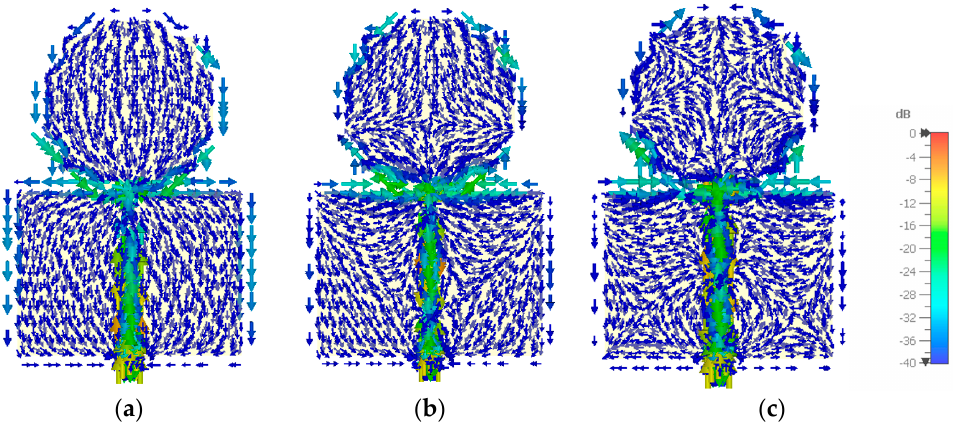
Figure 9. CST simulated normalized current distribution on the modified octagonal monopole configuration. ( a ) 0.7 GHz; ( b ) 2.1 GHz; ( c ) 3.5 GHz. The simulated far-field 2D radiation pattern results are shown in Figure 10.